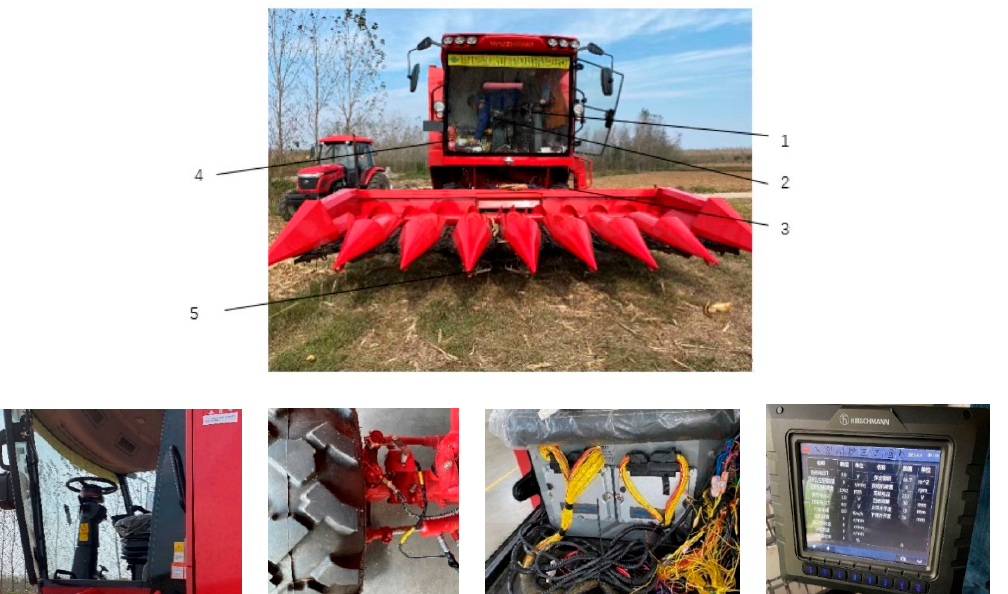
Figure 15. Experimental composition of automatic row alignment system for grain harvester (1) Power steering wheel (2) LCD display (3) Rear wheel angle sensor (4) Hirschmann IMC3653 controller (5) Touch-activated alignment mechanism.